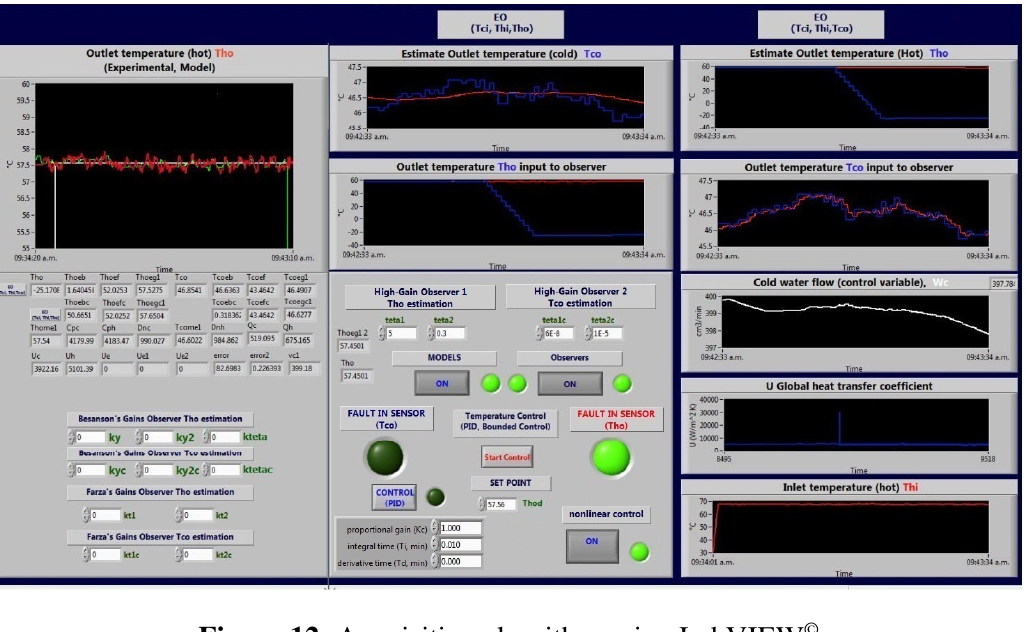
Figure 11. Fault-tolerant system.